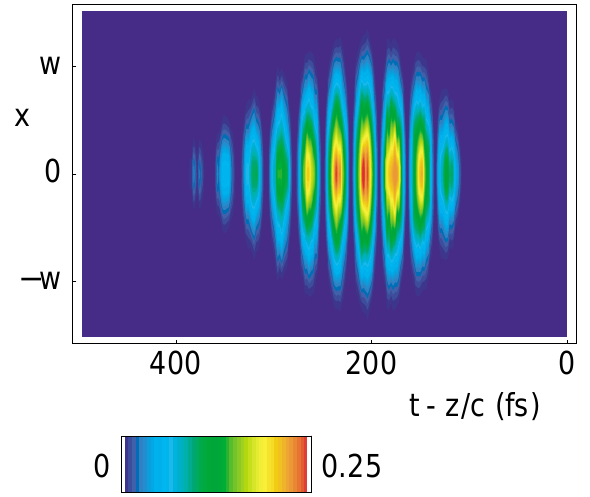
FIG. 2. (Color) Model for SMLW bunch: contour plot of bunch density n b in units of background density n e 0 as a function of x , t 2 z (cid:3) c .